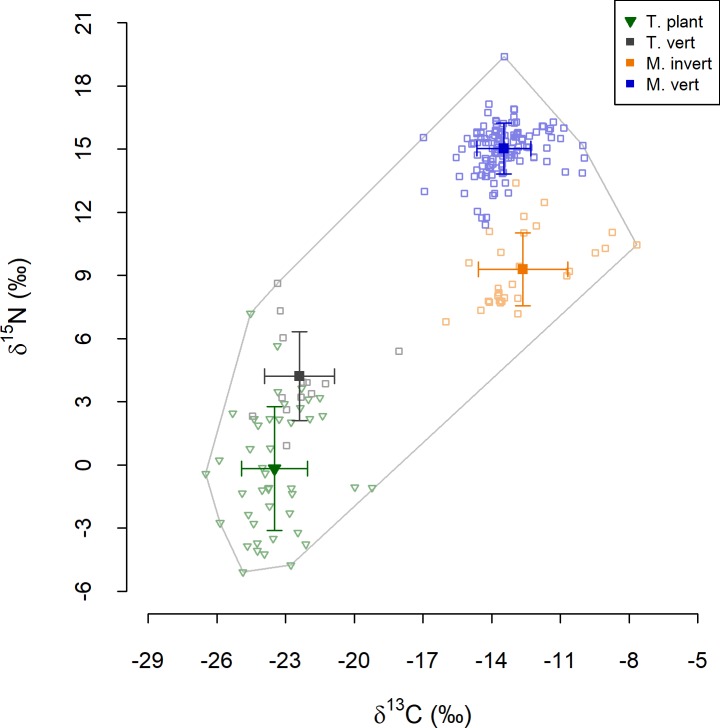
Isotope ratios of sources in models of Cape Peninsula Later Stone Age human diet.Open symbols denote raw values for individual plants and animals as indicated in the key. The grey outline indicates the minimum convex polygon around all raw values. Filled symbols and error bars show mean values and standard deviations for each group.